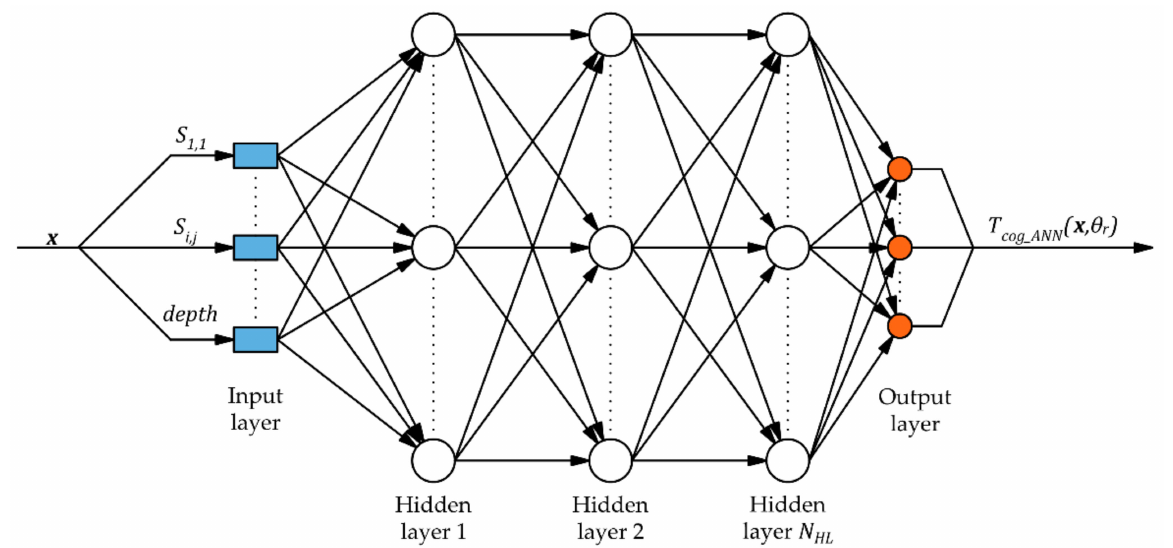
Figure 7. Architecture of the FF ANN used as surrogate model.